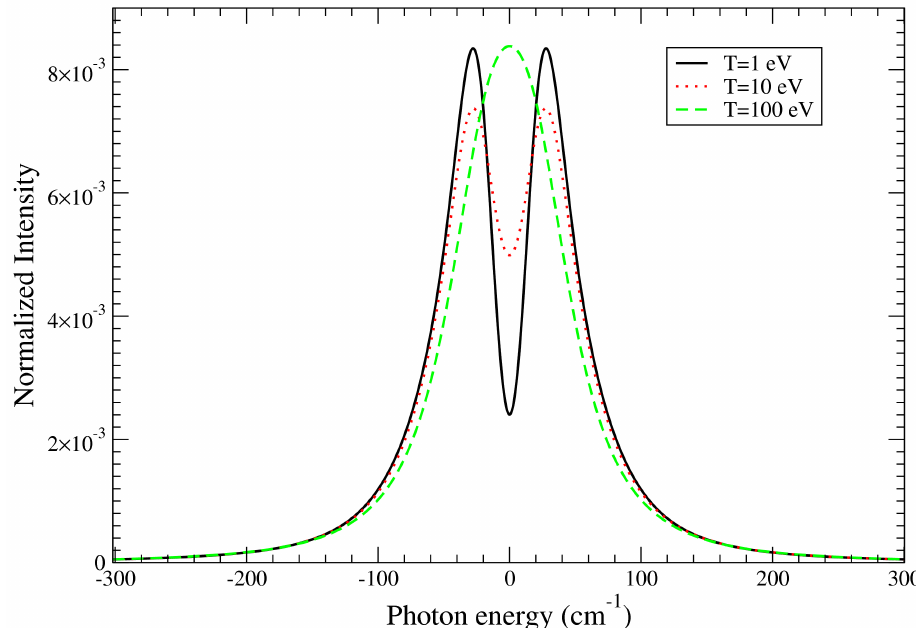
Figure 7. Lyman- β line shapes of Hydrogen at N e = 10 17 cm − 3 and various temperatures T = 1, 10 and 100 eV. The calculations were performed with the ZEST code accounting for ion dynamics effects (FFM) and assuming a Holtsmark microfield distribution. Doppler and electron broadenings have been omitted for the